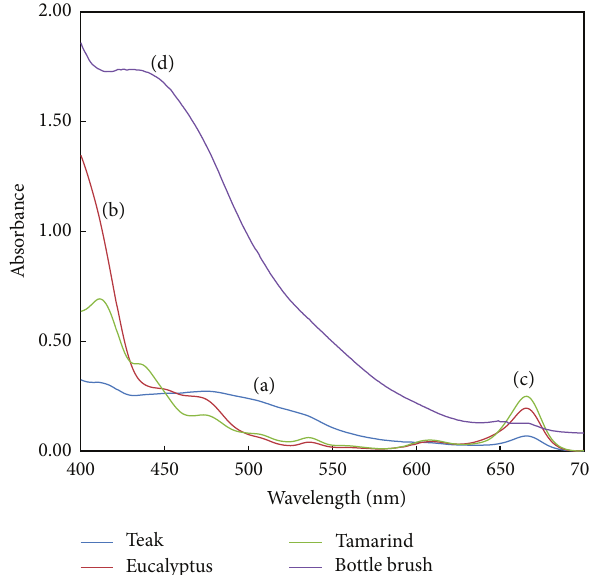
Figure 4: Absorption spectra of ethanol solution of natural dyes extracted from (a) teak, (b) eucalyptus, (c) tamarind, and (d) bottle brush,